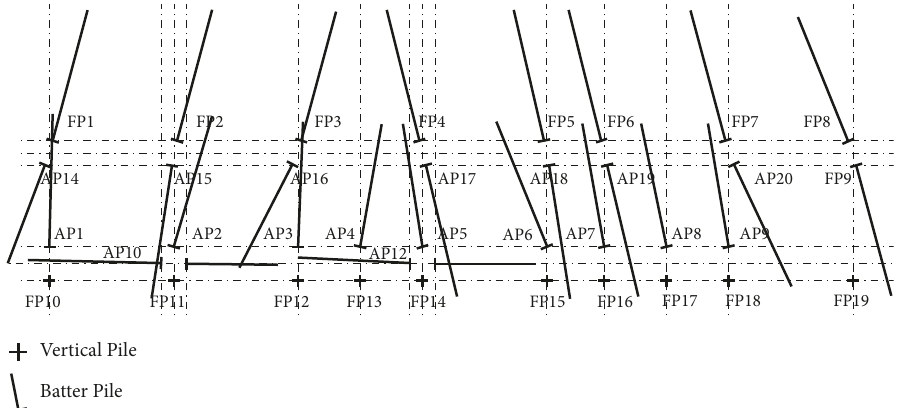
Figure 16: Pile arrangement given by the algorithm for case